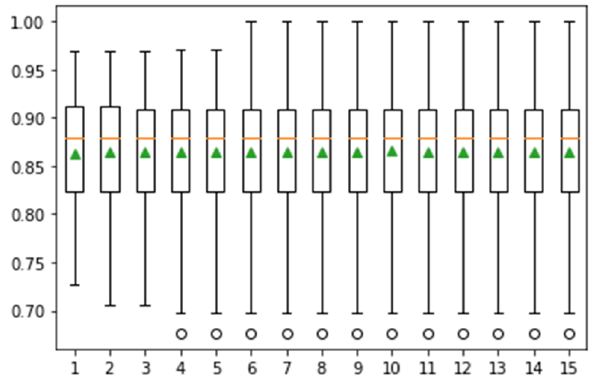
Figure 10. Confidence interval of classification accuracy by performing Monte Carlo simulation on 15 iterations using Messidor dataset. In Figure 10, the achieved classification accuracy is greater than 0.95. The classification results are computed on 20 iterations, as depicted in Figure 11.